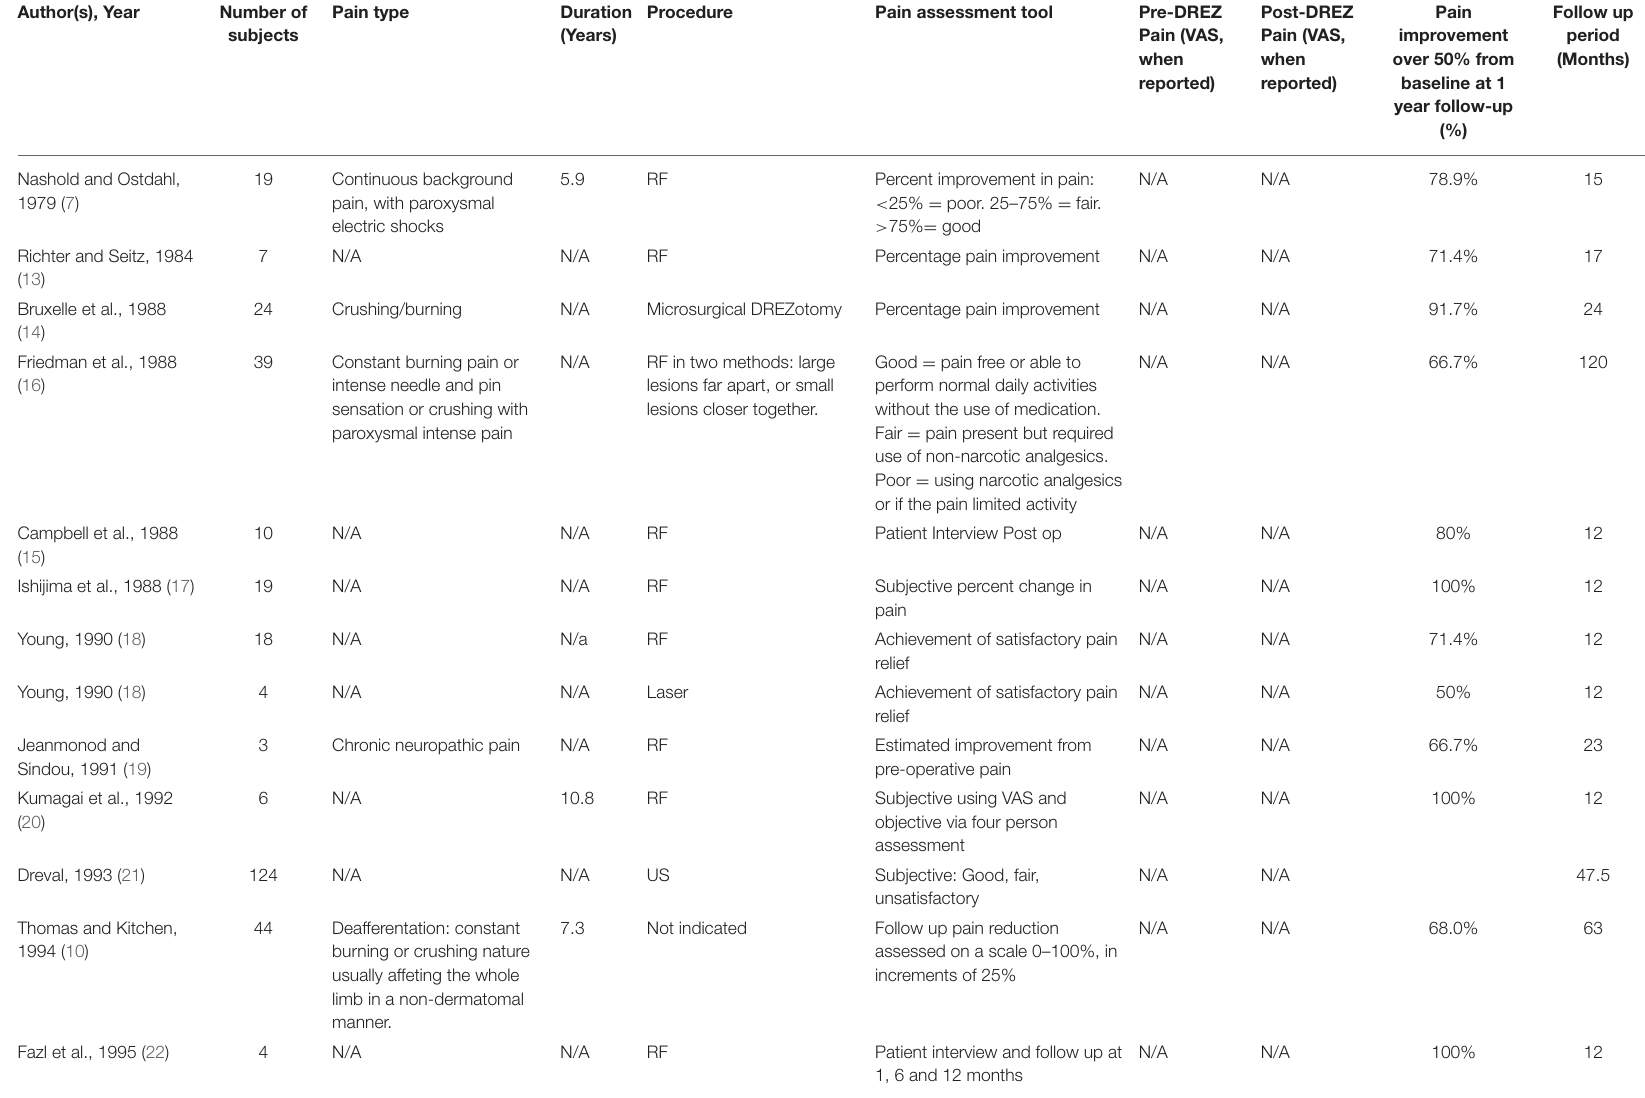
TABLE 2 | Summary of articles included in the systematic review of DREZ lesioning for brachial plexus